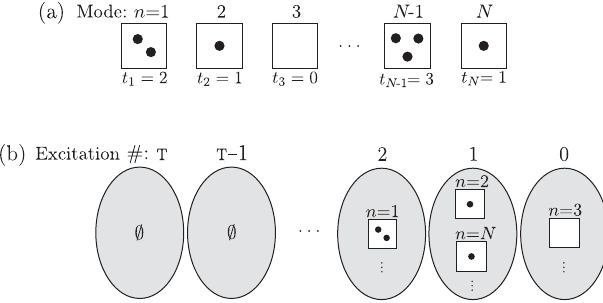
FIG. 6. Labeling schemes for difference-mode excitations. excitation